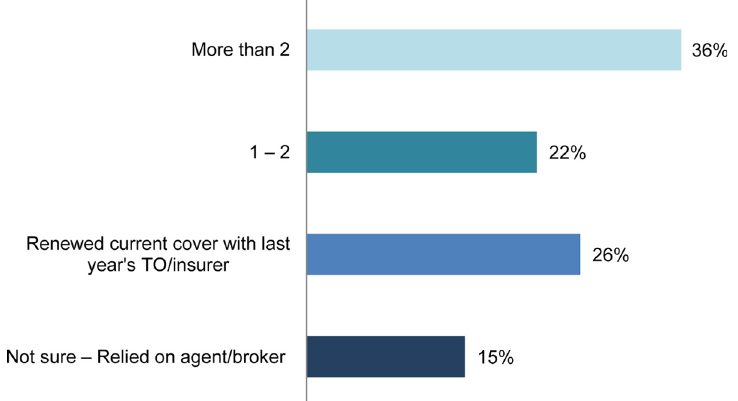
Figure 18. Number of providers approached for current tak (cid:1) aful or insurance